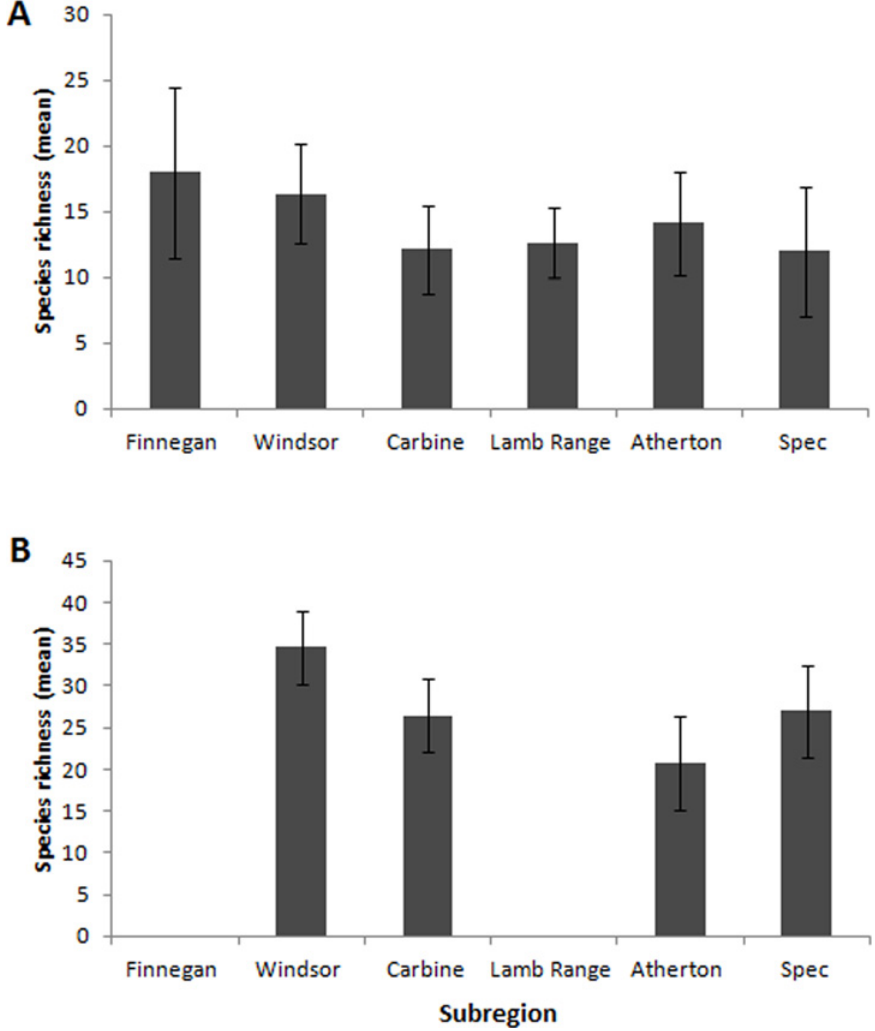
Fig 4. Mean site species richness at ( A ) all six subregions, using 2011 – 2012 wet season data, and ( B ) each of the four main subregions, based on data pooled across all sampling periods. Error bars represent 95% confidence intervals. In both cases there were no statistically significant differences between